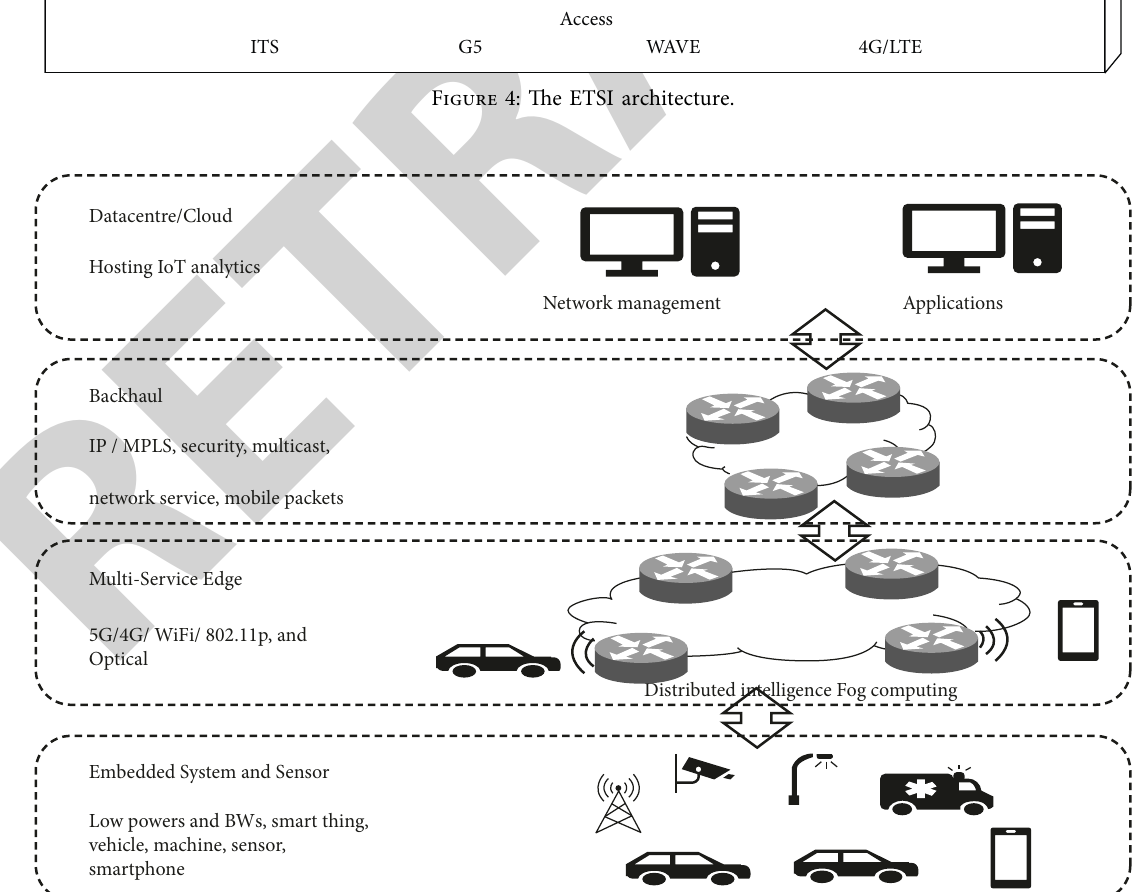
Figure 5: Cisco 4-layer